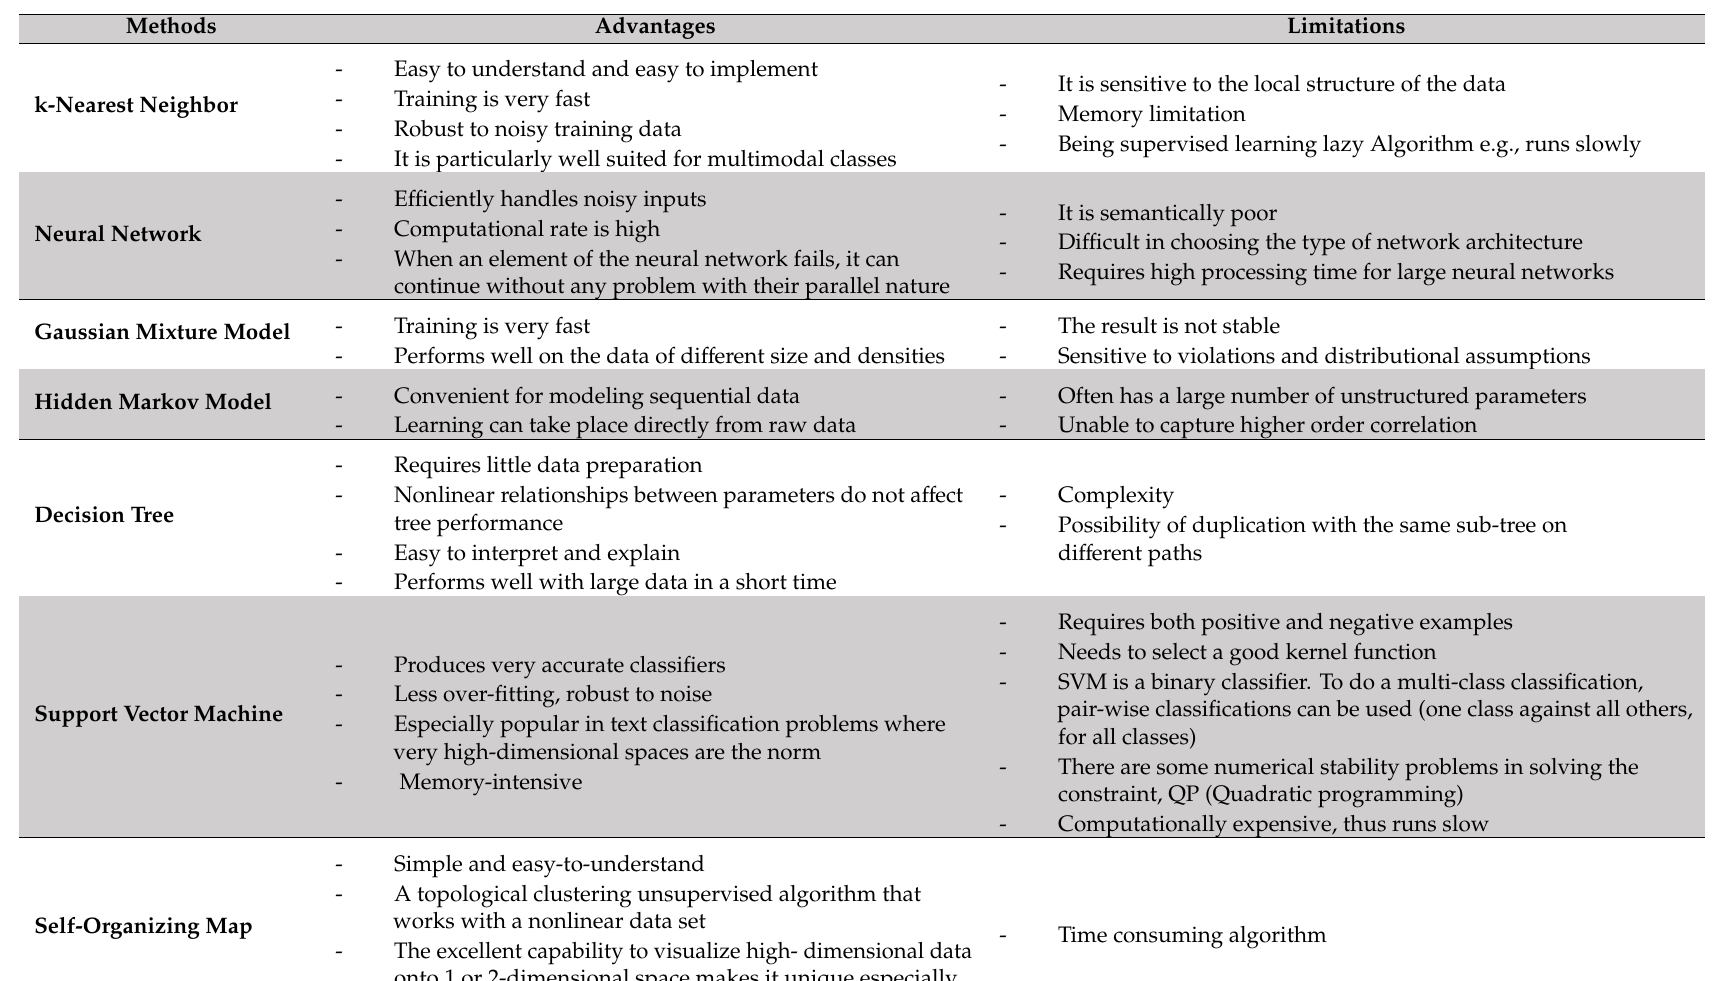
Table 6. Advantages and limitations of di ff erent classification